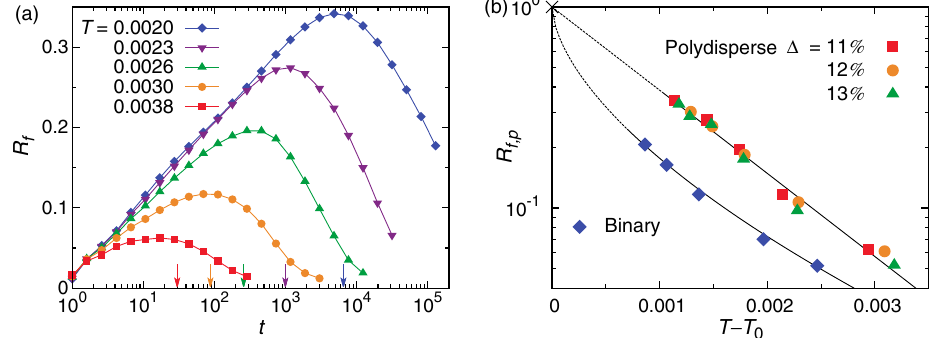
FIG. 6. Dynamic fluctuations with a structural origin. (a) The relative contribution from the structure to the overall dynamic fluctuations R for the 2D polydisperse system ( Δ ¼ 11% ) at different T . R is defined as the ratio of fluctuations with the structural f f origin to the overall value. See Sec. III for the detailed definition. The α relaxation time at each T is indicated by the arrow with the same color. (b) Dependence of the peak value of R , R , on T − T 0 . For 2D polydisperse systems, the data for the three systems with f f;p T Þ ¼ exp ½ − ð T − T 0 Þ = 0 . 001 05 (cid:2) . For the 2D different polydispersities ( Δ ¼ 11% , 12%, and 13%) collapse on a common curve of R f;p ð T Þ ¼ exp f − ½ð T − T 0 Þ = 0 . 0004 (cid:2) 0 . 6 g binary system, on the other hand, the data are fitted by R f;p ð